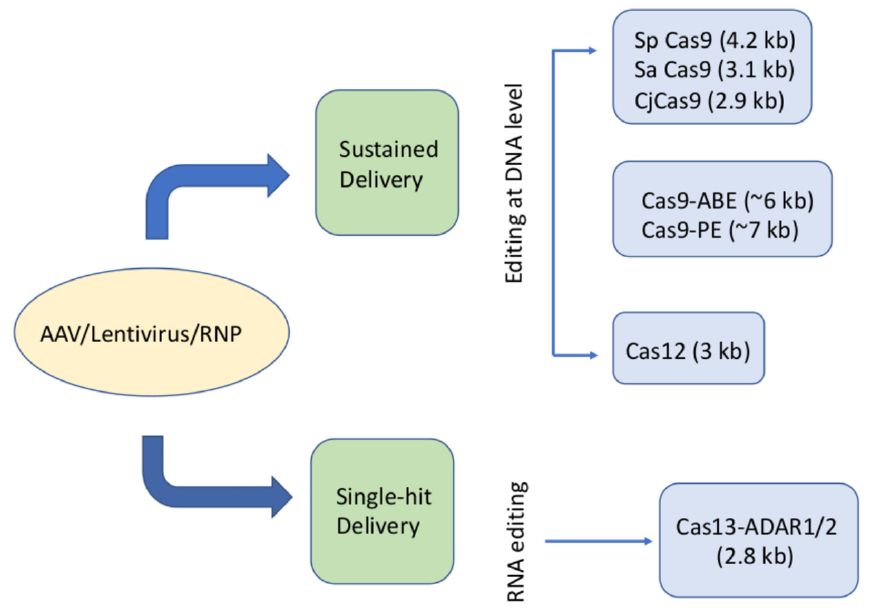
Figure 2. Different Cas-related proteins and their main characteristics for potential use in CRISPR- based gene therapies. A schematic diagram showing the different classes of Cas proteins used to target/edit retinal cells with their relative sizes. The current delivery platforms used with the CRISPR/Cas cargo are AAV, lentivirus, and ribonucleoproteins (RNPs). CRISPR editing can be achieved either in a sustained delivery acting on DNA or as a single-hit even acting on